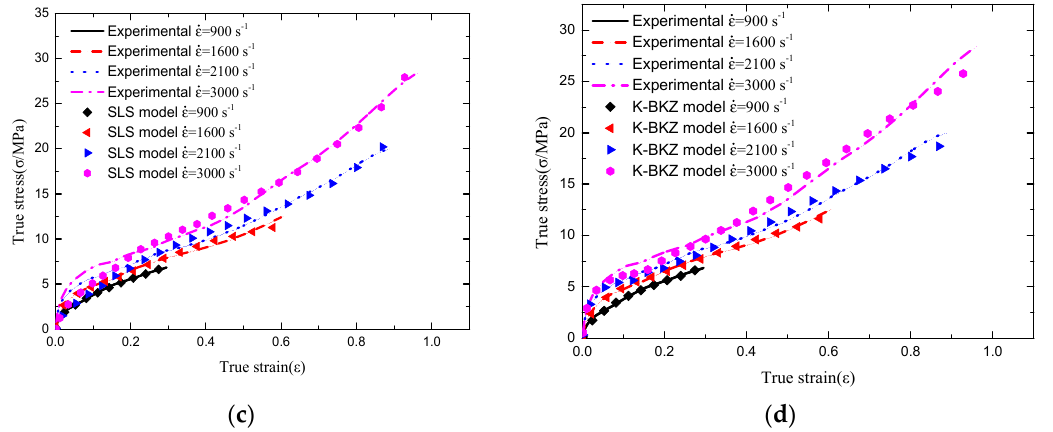
Figure 10. Comparison between experimental data and theoretical model: ( a ) quasi-static compression experimental data and Mooney-Rivlin model; ( b ) quasi-static compression experimental data and Ogden model; ( c ) SHPB experimental data and SLS model; and ( d ) SHPB experimental data and K-BKZ model.